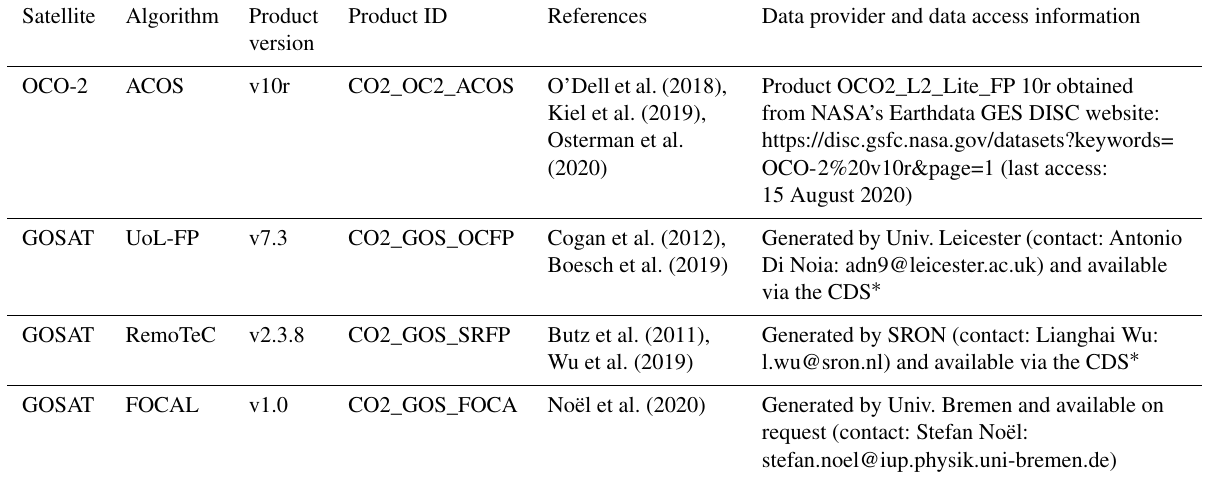
Table 1. Overview of the satellite XCO 2 Level 2 (L2) input data